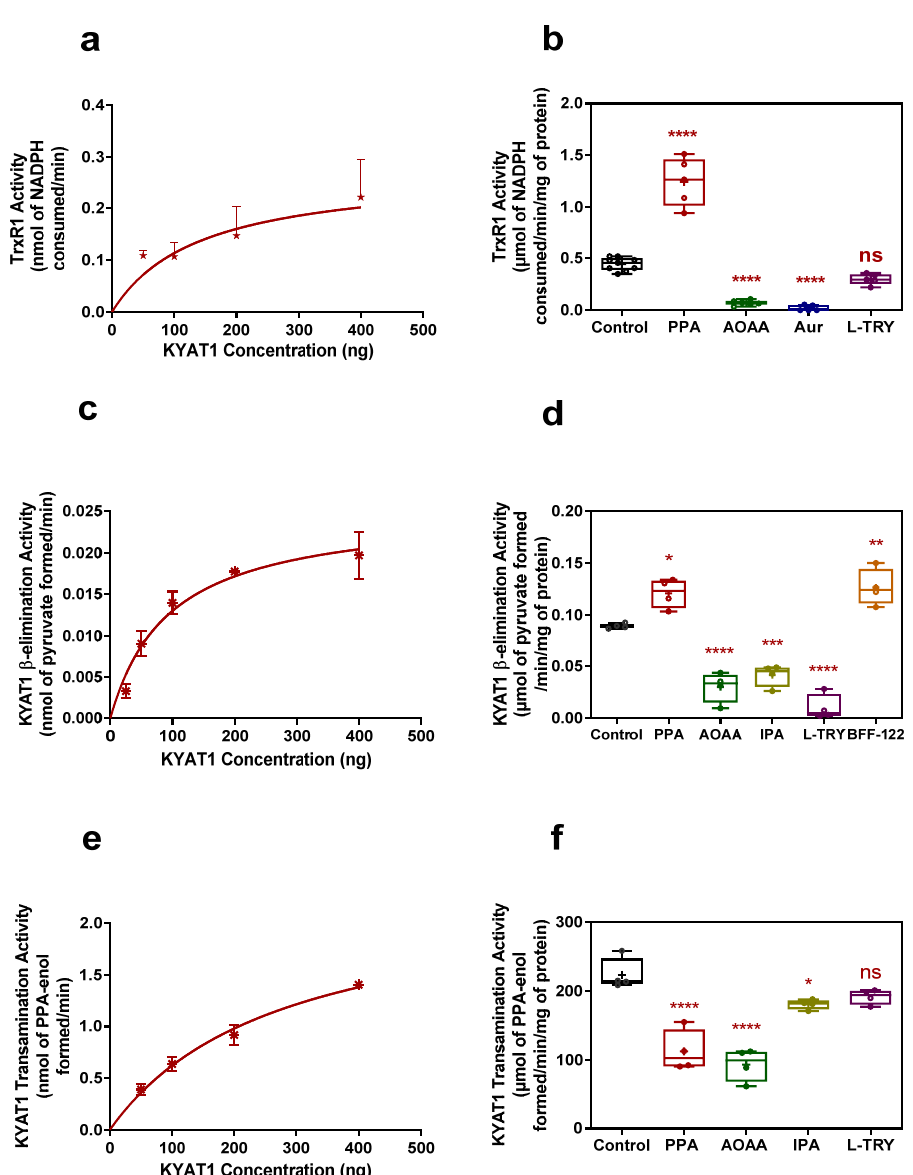
Figure 4. Transamination and β -elimination activity of KYAT1 with inducers and inhibitors ( a ) Coupled activity assay at 15 min, TrxR1 activity with varying KYAT1 enzyme concentration. The optimum KYAT1 concentration for maximum NADPH consumption at 15 min is 140 ng ( n = 7). ( b ) KYAT1 activity (100ng) in coupled activity assay with phenylpyruvic acid (PPA) (400 µ M), aminooxy acetic acid (AOAA) (1 mM), l -tryptophan ( l -Try) (2 mM) and auranofin (Aur) (100 nM) ( n = 5–9). ( c ) The pyruvate production with varying KYAT1 enzyme concentrations by modified β -elimination assay at 60 min. The maximum activity was shown at 95 ng of an enzyme concentration (1 / 2T max is 0.0125 nmol of pyruvate produced by 95ng of enzyme) ( n = 4). ( d ) KYAT1 activity (200ng) in β -elimination assay with phenylpyruvic acid (PPA) (400 µ M), aminooxy acetic acid (AOAA) (1 mM), indole-3-pyruvic acid (IPA) (100 µ M), l -tryptophan ( l -Try) (2 mM) and BFF-122 (50 µ M) ( n = 4). ( e ) Transamination activity of KYAT1 enzyme at di ff erent concentrations. The optimum KYAT1 concentration for maximum phenylpyruvate-enol formation at 30 min was 274 ng ( n = 4–5). ( f ) Transamination activity of KYAT1 (50 ng) with phenylpyruvic acid (PPA) (400 µ M), aminooxy acetic acid (AOAA) (1 mM), indole-3-pyruvic acid (IPA) (100 µ M) and l -tryptophan ( l -Try) (2 mM) ( n = 4). Bar graphs in ( b ) ( d ) and ( f ) represent mean ± SD, statistical analysis performed with one-way ANOVA with 95% confidential interval followed by Dunnett multiple comparison test (ns = not significant, * p < 0.05, ** p < 0.01, *** p < 0.001 and **** p < 0.0001 compared with